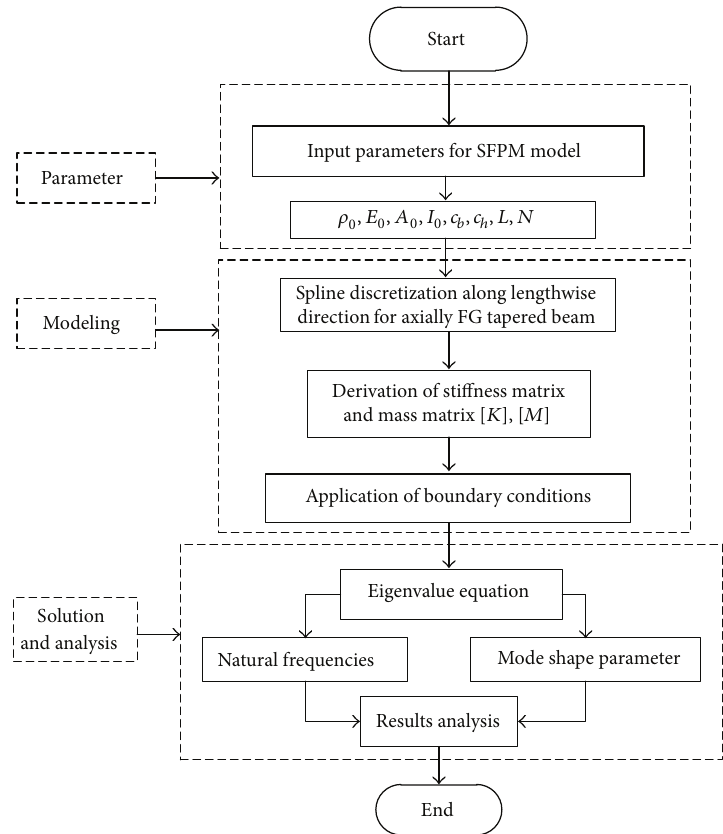
Figure 4: Flowchart of free vibration analysis of axially FG tapered beam via SFPM.